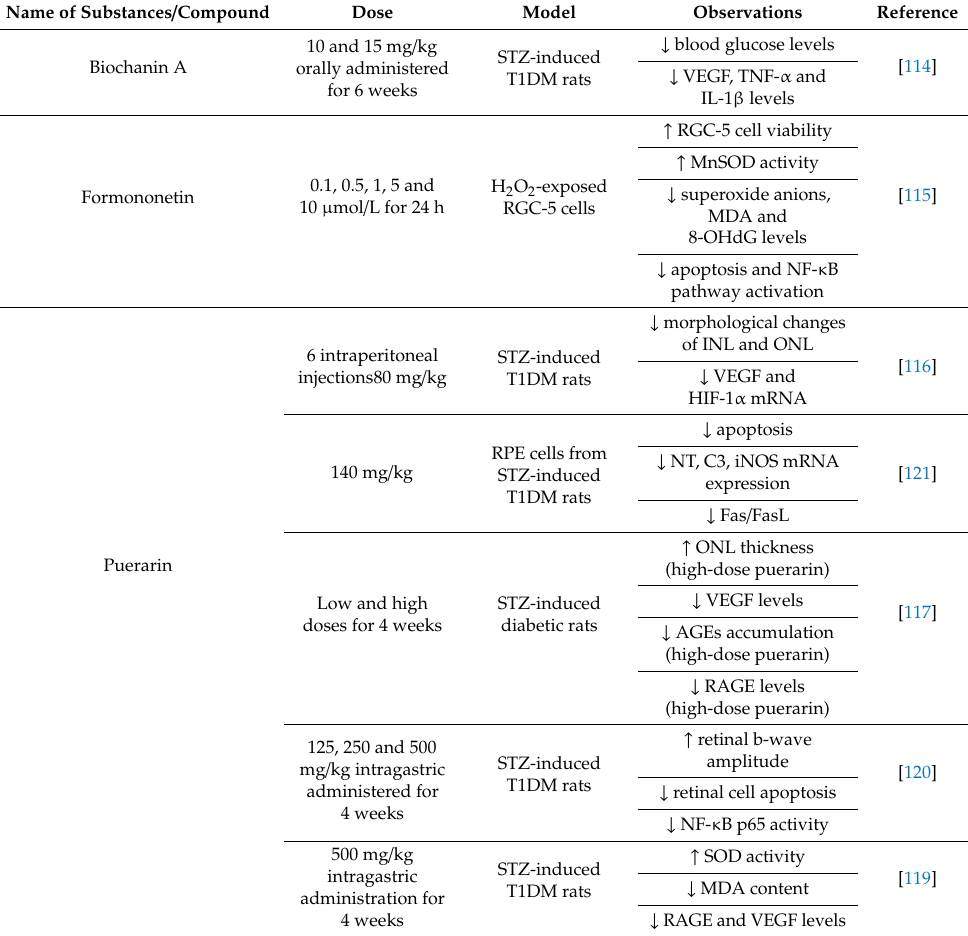
Table 6. E ff ects of isoflavones on cellular and molecular mechanisms a ff ected by diabetic retinopathy. Name of Substances /